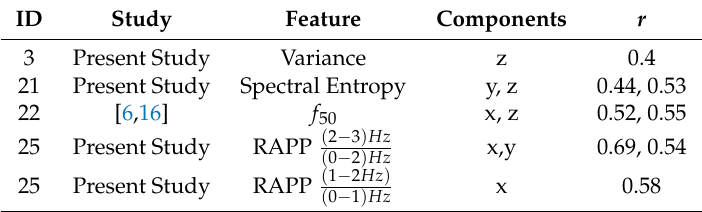
Table 5. The most significant and non-redundant features, computed by means of Algorithm 1. ID